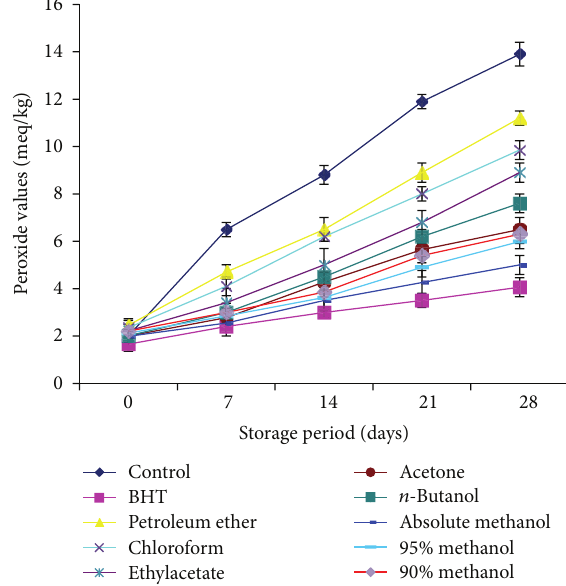
Figure 5: Relative increase in conjugated dienes content (CD) of sunflower oil stabilized with C. viminalis leaves